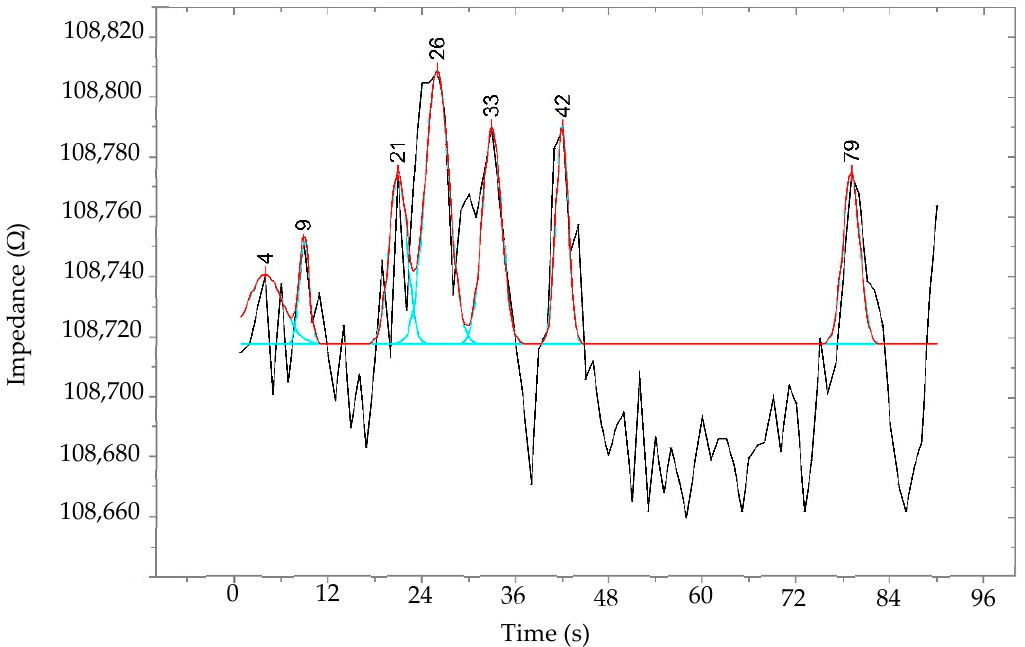
Figure 5. The peak impedance distribution of sperm when passing the electrode, showing the number of times which the motile sperm signals were detected within 90 s.